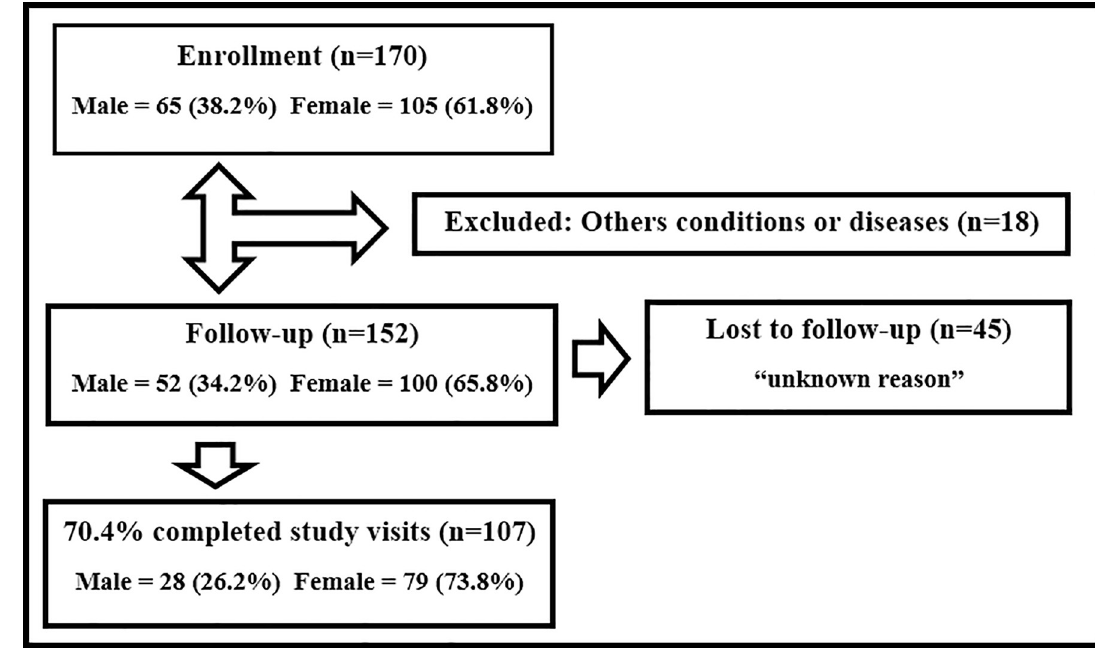
Fig 1. Flow diagram of INOVACHIK Cohort